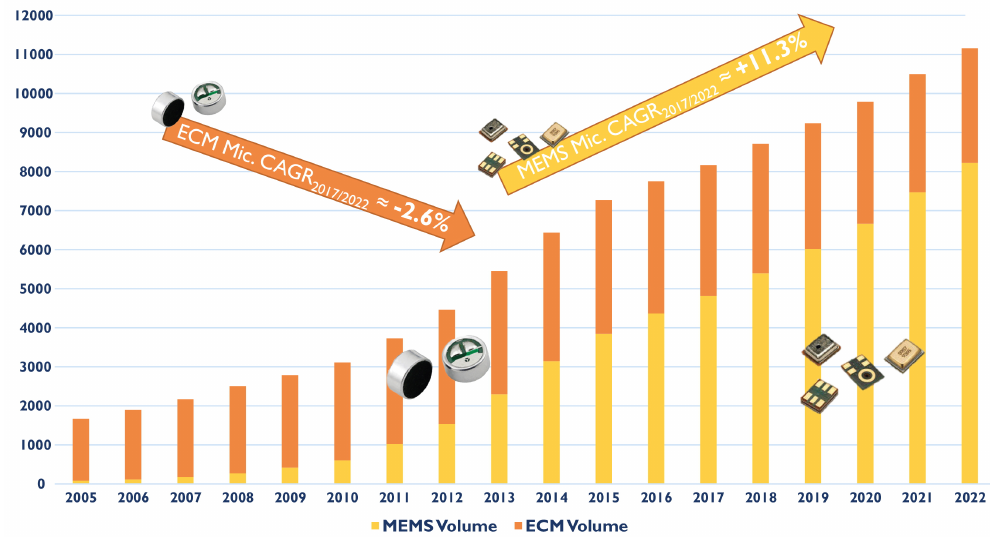
Figure 1. The microphone market in million units since 2005